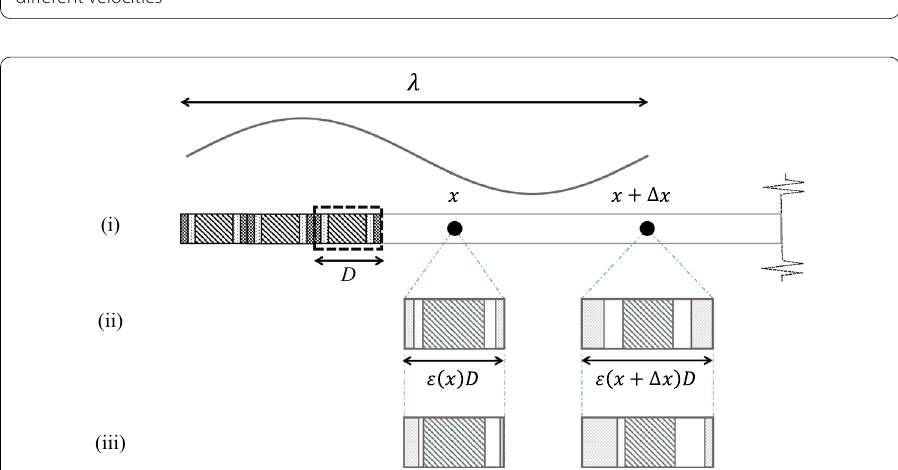
Fig. 1 Possible transient responses within a unit cell when a macro point x is subjected to velocity v ( x ): i the entire unit cell moves with the same velocity; ii the stiff layer, compliant layers and matrix material move at different velocities